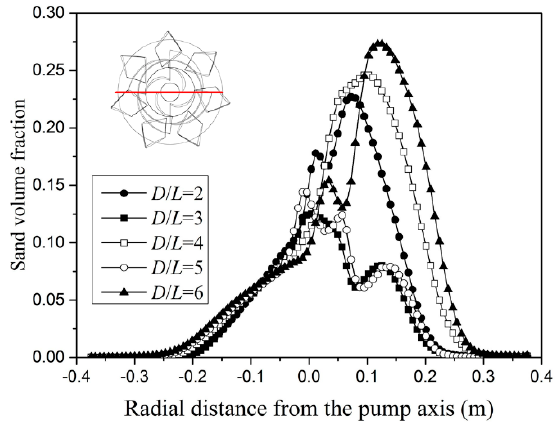
Figure 10. Distributions of the sand volume fraction over the centerline of the pump inlet section.